Question: Summarize what this figure shows in one sentence.
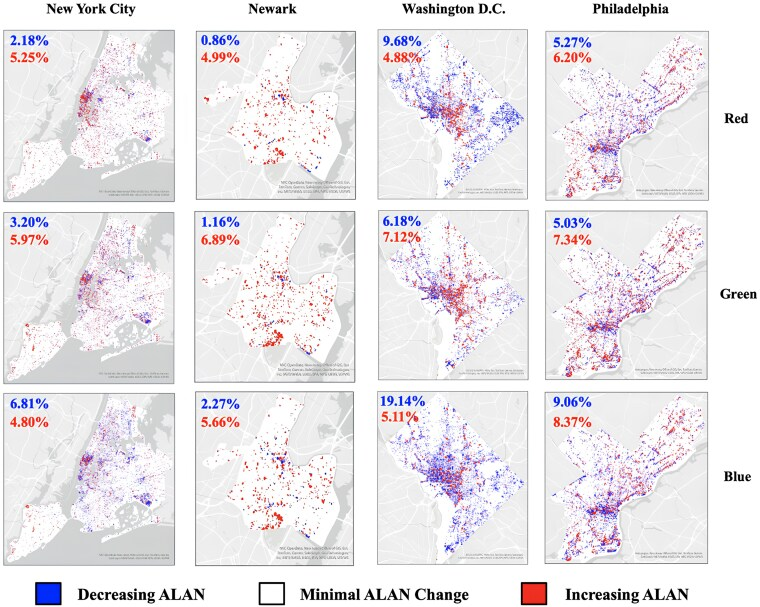
Answer: Spatial patterns of ALAN difference between 2022 and 2023 for each city and spectral band. Pixels within the range of ±mean difference of each city for each band are classified as “Minimal ALAN Change” and marked in white. Those exceeding the +mean difference are marked red (“Increasing ALAN” in 2023 compared with 2022), and those below the −mean difference are colored blue (“Decreasing ALAN”). The percentage of pixels under each classification is listed in the top left corner of each map, respectively.